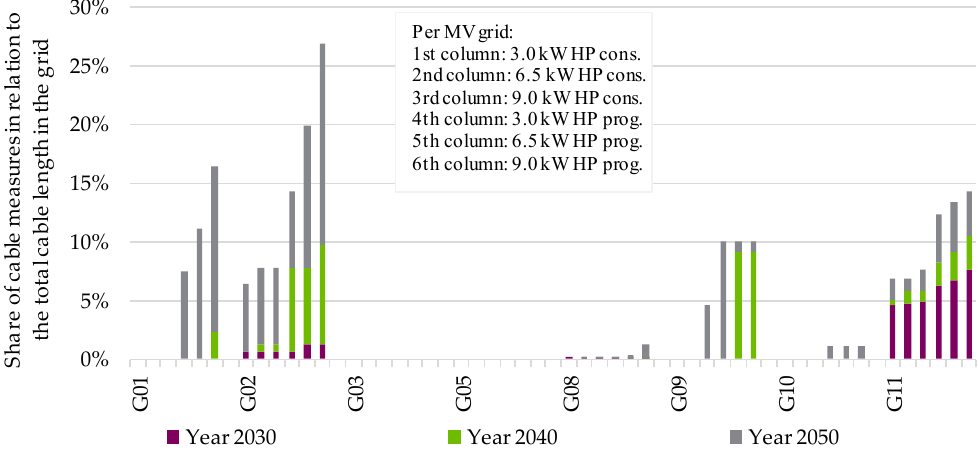
Figure 19. Share of the length of required cable measures in comparison to the total cable length in the grid for the two development scenarios over three years until 2050 based on [59].